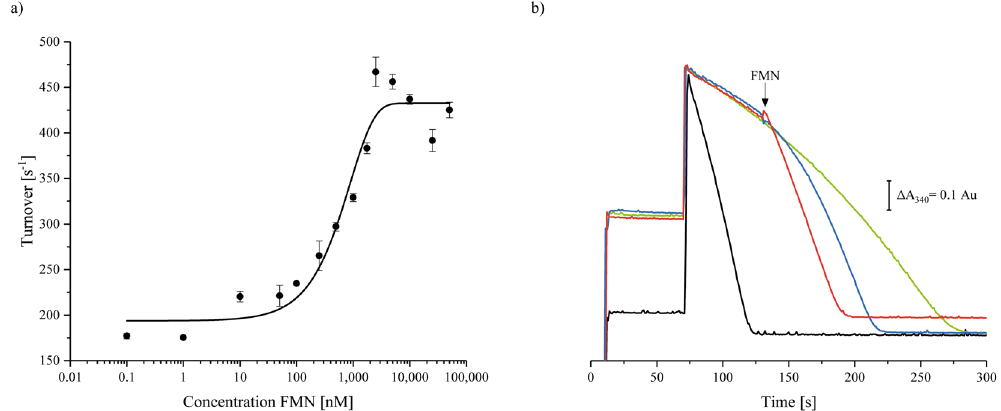
Figure 3. Activation of the NADH:ferricyanide oxidoreductase activity of complex I by externally added FMN. The assay contained 150 µ m NADH and 10 nm E. coli complex I in 50 mm MES/NaOH, 50 mm NaCl, pH 6.0. The reaction was started by an addition of 1 mm ferricyanide and FMN was added after 60 sec. ( a ) The maximum activity obtained is plotted against the concentration of externally added FMN and the data points are fitted as a sigmoidal curve. ( b ) Shows the activity without an addition of FMN (green) and with an addition of either 1 µ m (blue) or 10 µ m (red) FMN (indicated by an arrow). The black curve shows the reaction started by an addition of